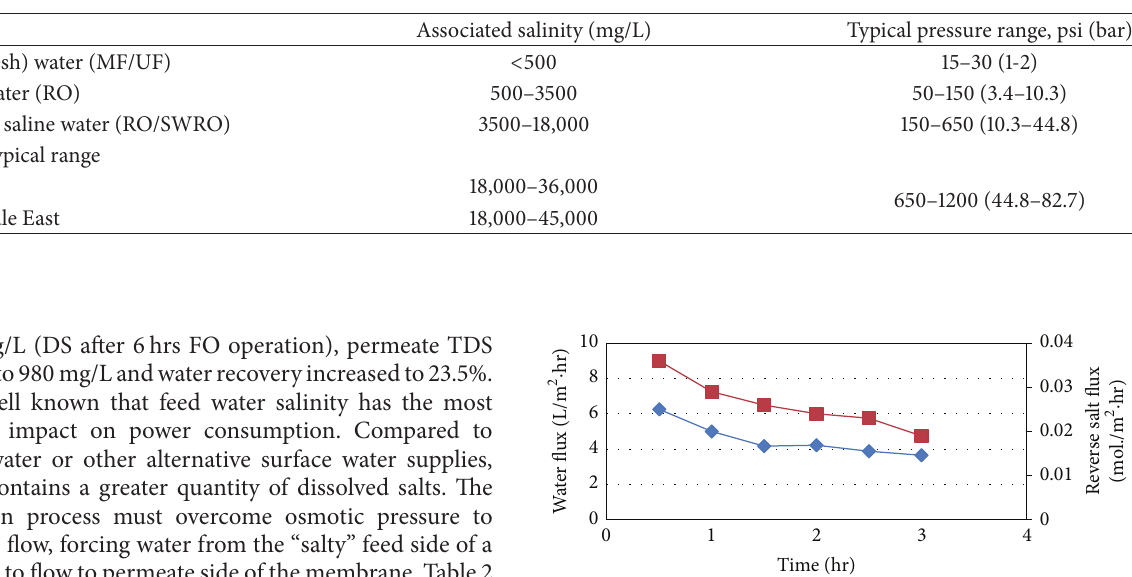
Table 2: Source water quality and pressure requirements.